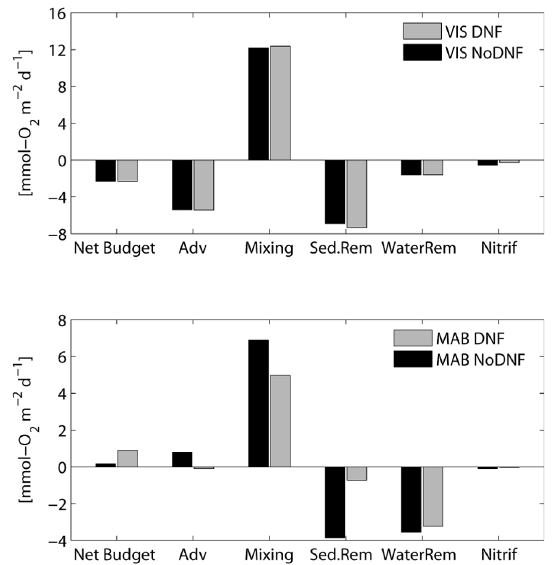
Fig. 5. Contributions to the O 2 budget for the bottom 10m of the water column of the modelled shelves (depth ≤ 200m), averaged over the 75 days of the analysis period: (top) VIS and (bottom) MAB. Experiments with and without denitrification in the sedi- ments are shown as grey and black bars, respectively. The bottom axis reads: net budget (sum all of budget terms), advection (horizon- tal plus vertical), vertical mixing, sediment remineralization, rem- ineralization of organic matter in the water column and nitrification in the water column. Positive fluxes are into the near-bottom